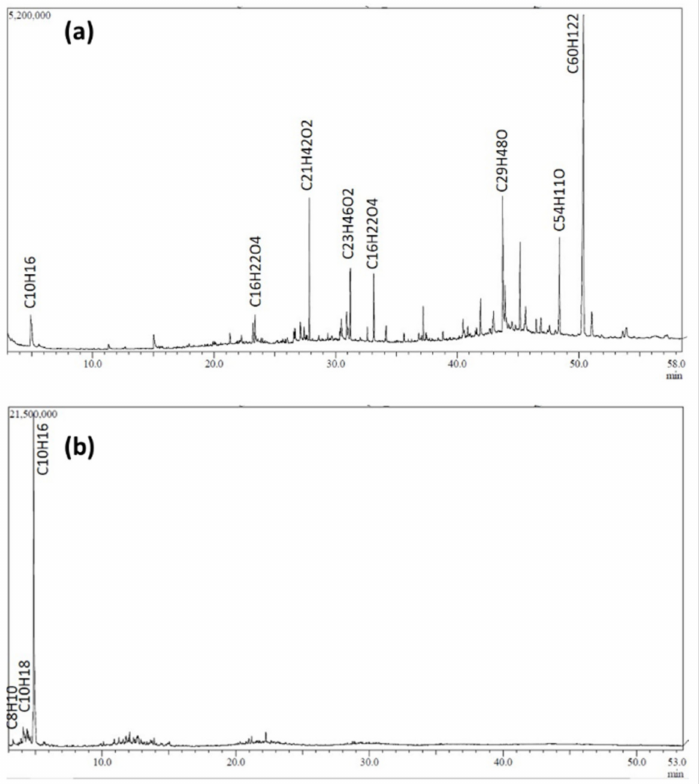
Figure 4. GC-MS chromatogram profile of waste NRG and its fraction. ( a ) NRG-S and ( b ) NRG-L.